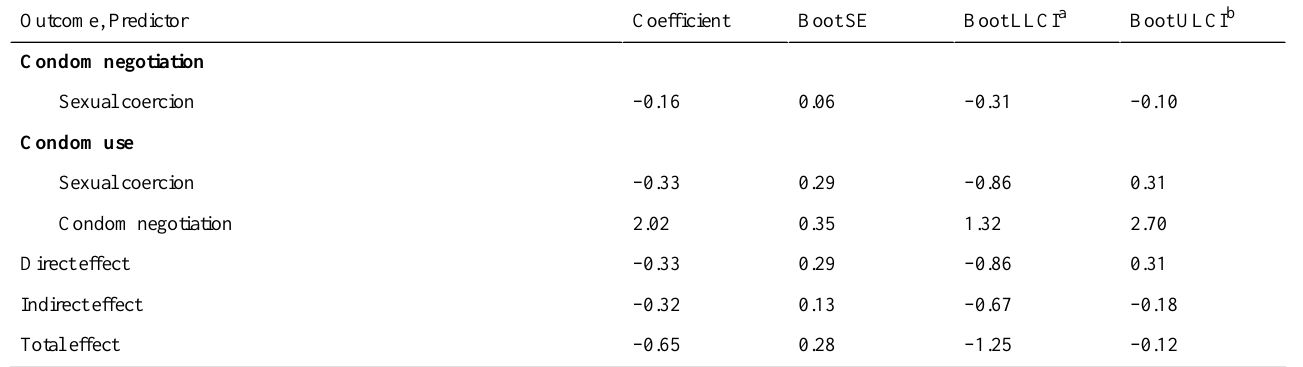
Table 2. Mediation results for condom negotiation.